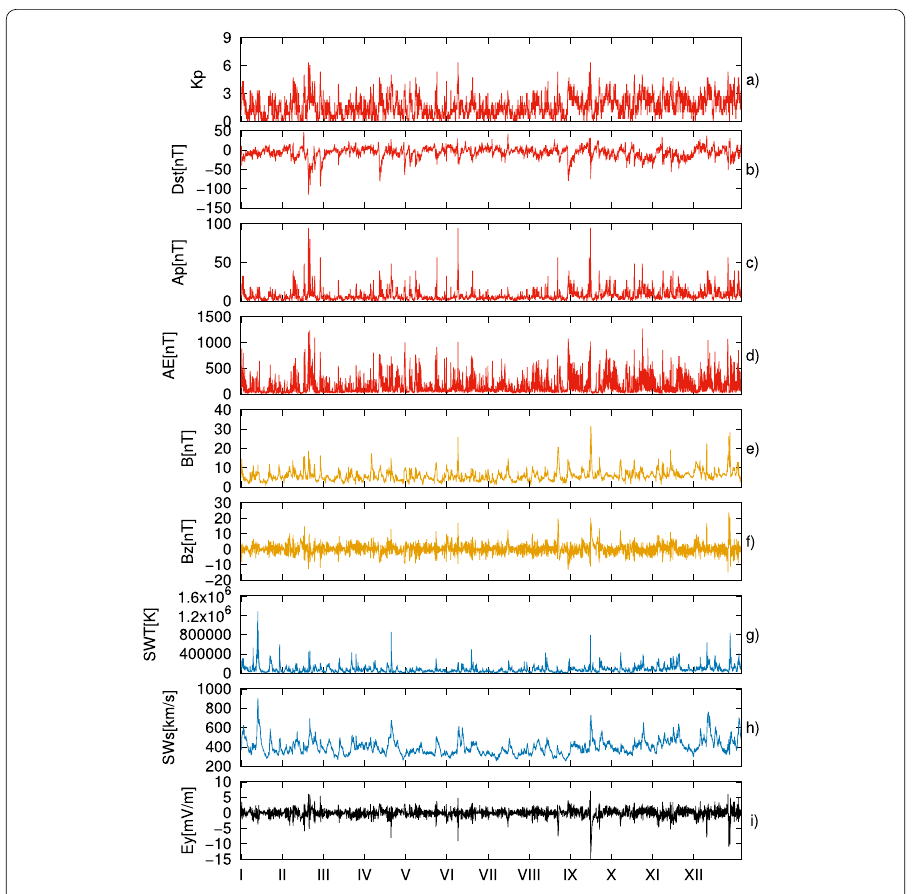
Figure 4 Hourly data of geomagnetic indexes: ( a ) Kp , ( b ) Dst , ( c ) Ap , ( d ) AE ; heliospheric magnetic field: ( e ) strength, ( f ) Bz component; solar wind: ( g ) temperature, ( h ) speed; and ( i ) electric field in